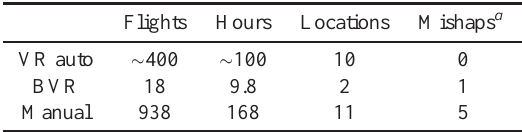
Table 2: Flight statistics of four